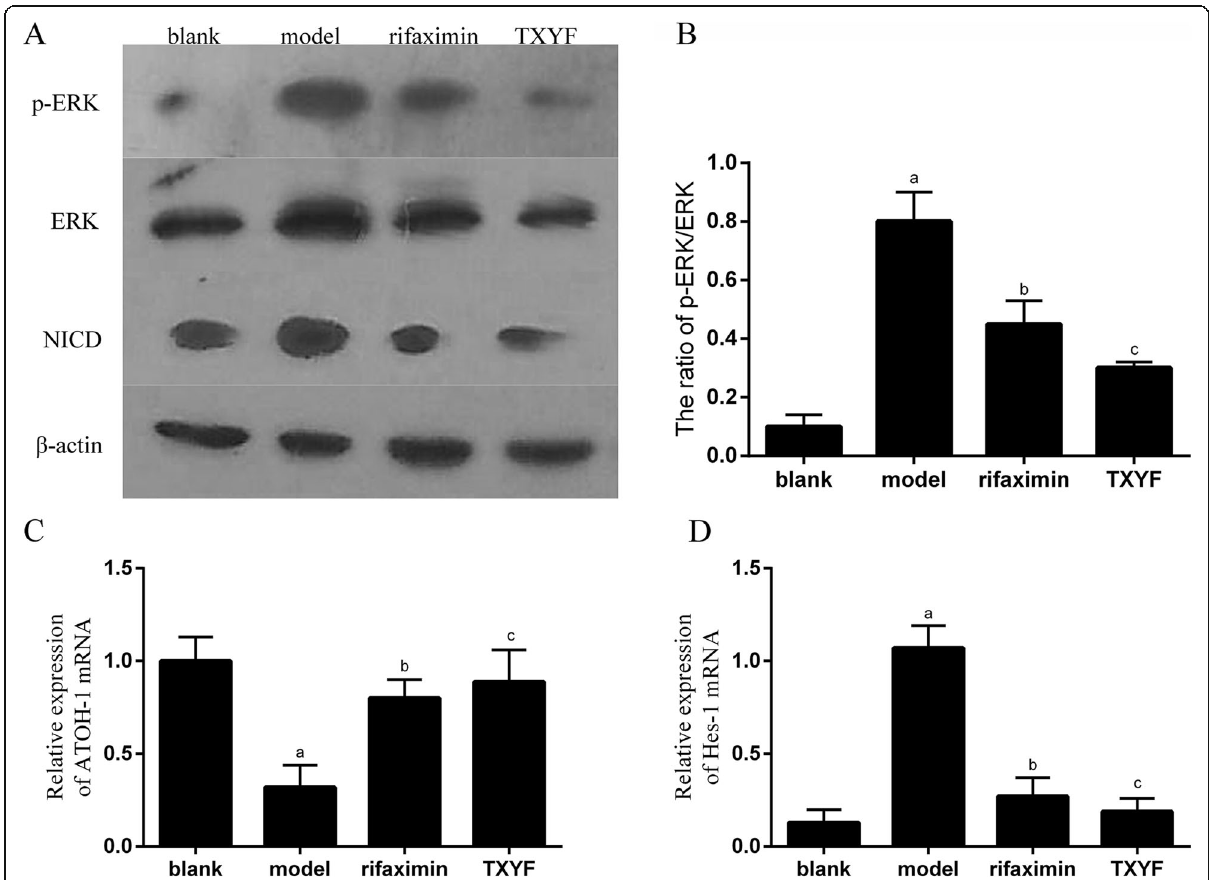
Fig. 4 TXYF inhibits the Notch signalling pathway in IBS-D rats. a Western blot analysis for the expression of NICD, p-ERK and ERK in distal colonic tissues. b The ratio of p-ERK/ERK. c , d qRT-PCR detection of Hes-1 and ATOH1 in distal colonic tissues. a P < 0.05 vs the blank group. b P < 0.05 vs the model group. c P > 0.05 vs the rifaximin